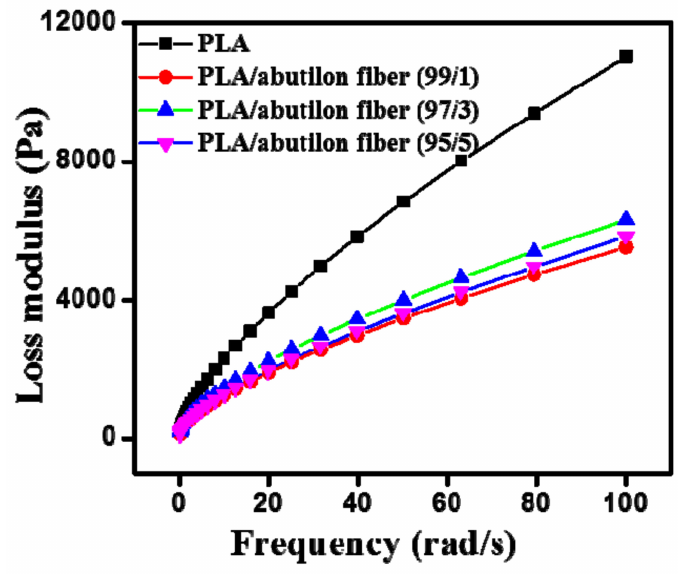
Figure 10. The loss modulus of (PLA / abutilon fiber)